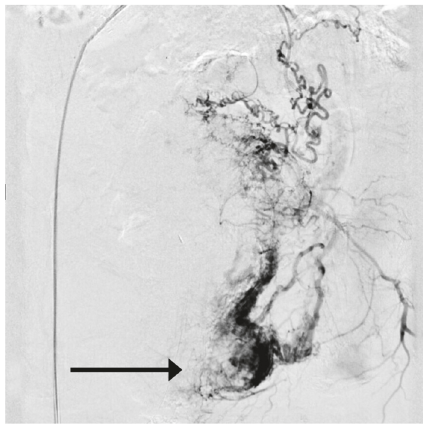
Figure 3: Pelvic arteriogram demonstrating a large hypervascular blush with active extravasation (arrow) along the left side of the vagina consistent with metastatic